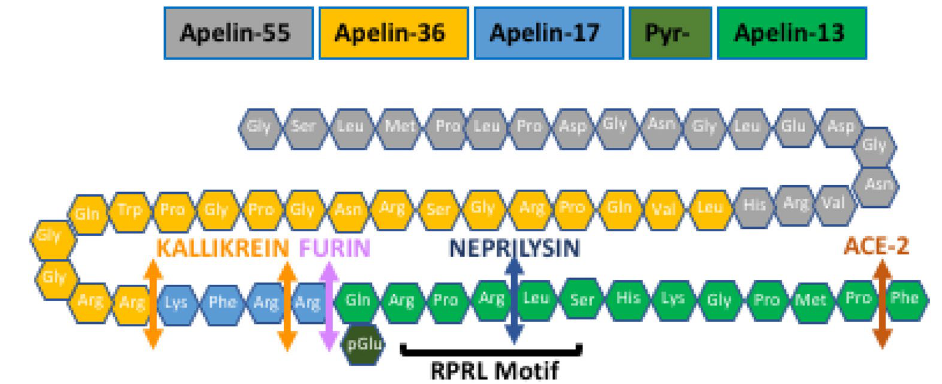
Figure 1. Structure of proapelin. Selective representation of the best characterized peptide fragments. Apelin-55 is processed to several active and inactive isoforms with a short half-life that have not been